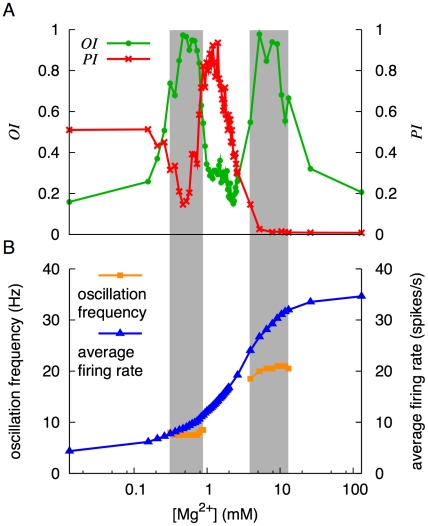
Dynamical states of the network during a current injection (I
MF = 22.7 pA) with various concentrations of Mg2+.
A, Dependence of the oscillation index (OI) and POT representation index (PI) on the concentration of Mg2+. OI was large in two separate regions of Mg2+ concentration, which are indicated by the vertical gray bands. In-between these gray bands, there is a domain in which PI was larger than 0.5. B, Average firing rate of grcs and frequency of oscillatory spike generation. The average firing rate increased monotonically as the Mg2+ concentration increased. The oscillation frequency was around 7 Hz within the interval of 0.417–0.782 µM and around 20 Hz within the interval of 5.21–9.13 µM.